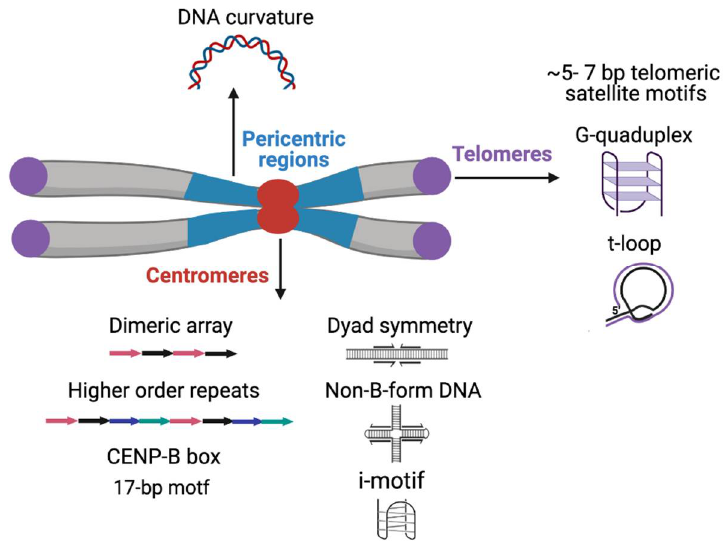
Figure 1. Sequence motifs, basic organizational units and predicted non-B-form secondary DNA structures on various functional classes of satellite DNA.